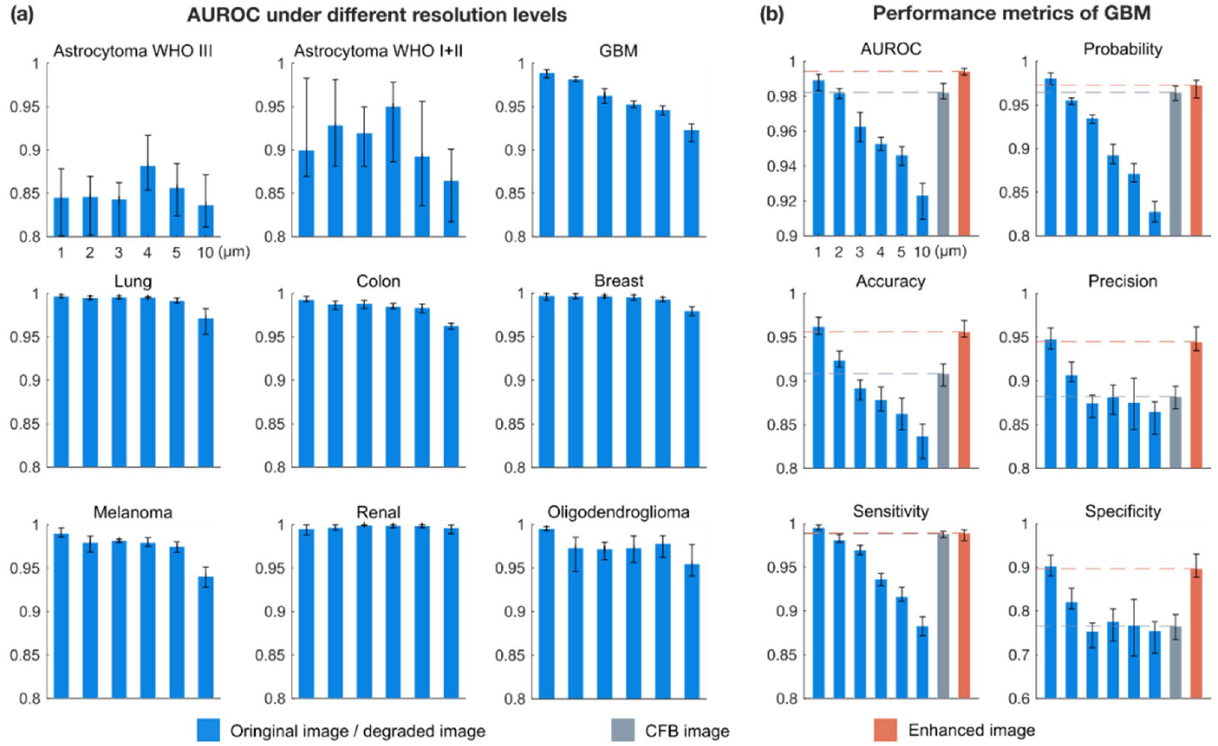
Figure 5. Comparison of classification performance for different image types. ( a ) AUROC values of the classification networks trained on different resolution levels. ( b ) The classification performance for GBM. The classification networks are individually trained and predicted for each data type CFB images and resolution enhanced images. All the results are based on TPEF